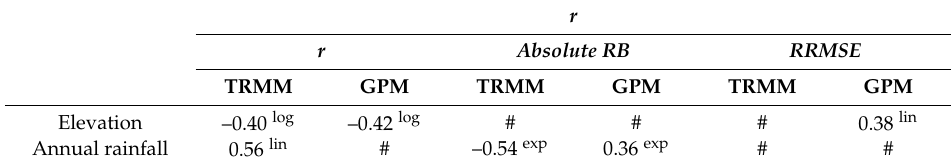
Table 3. Regression results of three statistical metrics versus elevation and annual rainfall at all gauge stations.